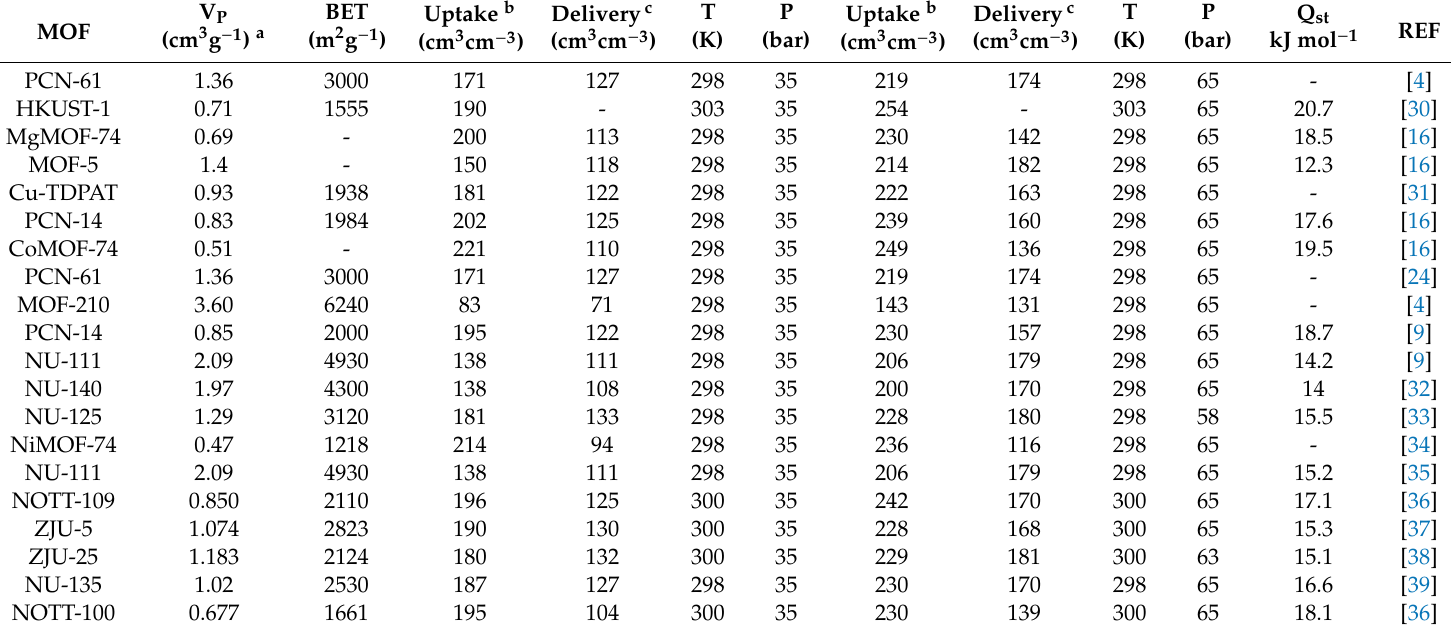
Table 1. Pore volume, uptake, and deliverable capacity of selected MOFs. Table adapted from Reference